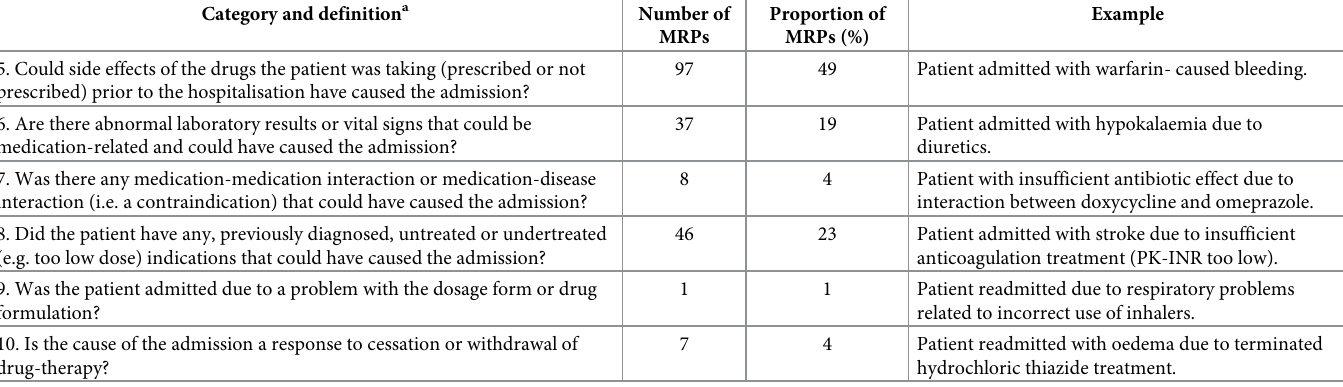
Table 3. Categorisation of medication-related problems in patients possibly readmitted due to medications—As assessed by